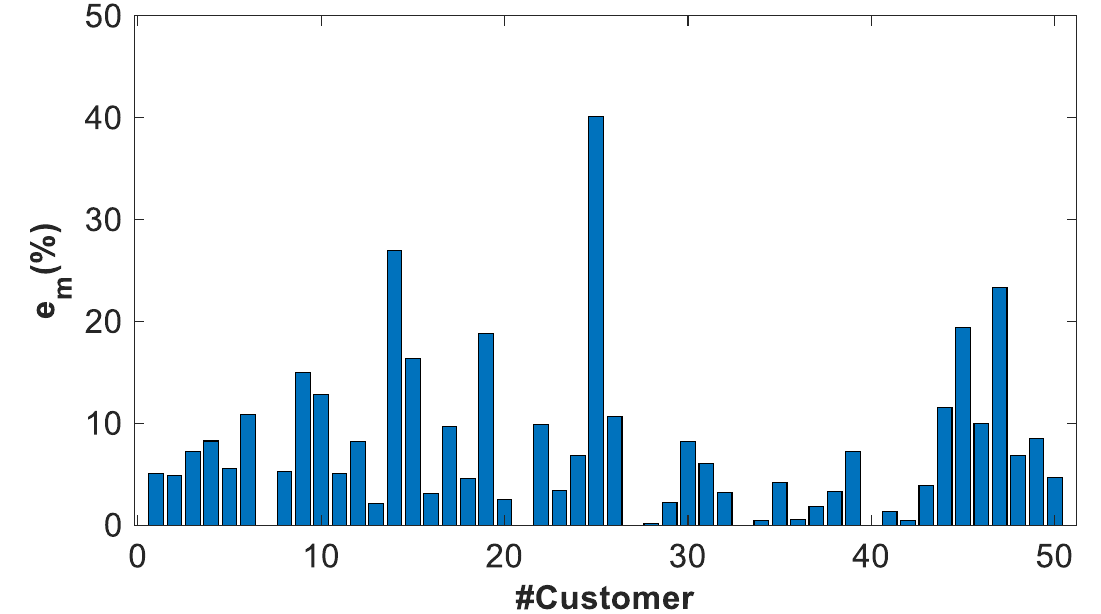
Figure 20. The partial error of the full energies profiles, (cid:99) Y m , with the respect to the estimate power profile (cid:98) Y , obtained using the reference algorithm without the clustering phase. The error is normalized by normalized by the upper bound of the contractual power of the subset of considered power profiles (i.e., P = 16.5 kW).